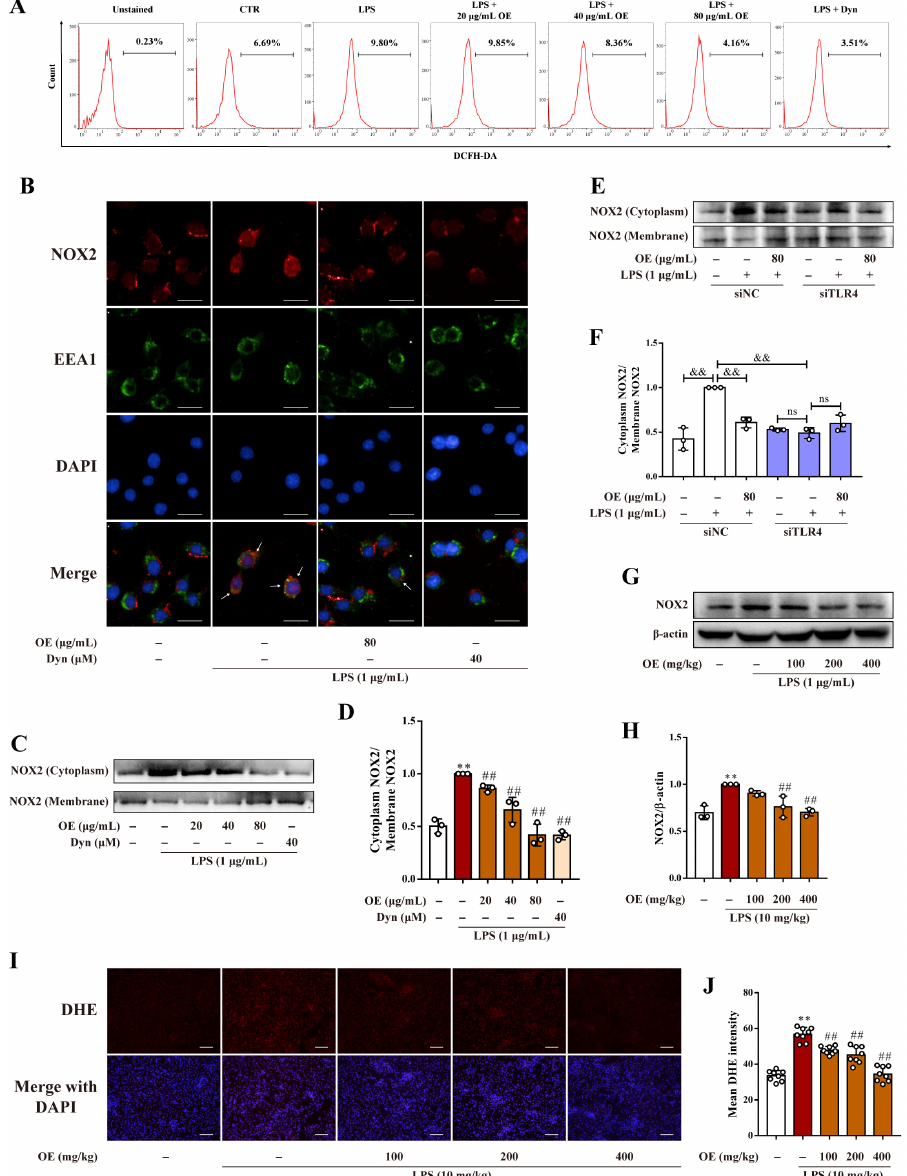
Figure 5. OE diminished ROS production by inhibiting NOX2 endocytosis. ( A ) RAW264.7 macrophages were pretreated with OE (20, 40, 80 µ g/mL) for 3 h or with Dyn (40 µ M) for 30 min fol- lowed by stimulation with LPS (1 µ g/mL) for 6 h. ROS production was measured by a ROS detection kit via flow cytometry. ( B – D ) RAW264.7 macrophages were pretreated with OE (80 µ g/mL) for 3 h or with Dynasore (40 µ M) for 30 min followed by stimulation with LPS (1 µ g/mL) for 4 h. Co-localization between NOX2 and EEA1 was determined by immunofluorescent staining (B). Scale bars: 20 µ m. The cytoplasmic and membranal protein expression of NOX2 were determined by a western blotting assay ( C , D ). ( E , F ) After transfecting siNC (100 nM) or siTLR4 (100 nM), RAW264.7 macrophages were pretreated with OE (80 µ g/mL) for 3 h followed by stimulation with LPS (1 µ g/mL) for 4 h. Cytoplasmic and membranal protein expression of NOX2 were determined by a western blotting assay. ( G – J ) Mice were administered OE (100, 200, 400 mg/kg) by gavage for 7 days followed by intraperitoneal injection of LPS (10 mg/kg) and feeding for another 12 h. The total protein expression of NOX2 ( G , H ) and ROS production ( I , J ) in mice kidneys were determined by a western blotting assay and DHE staining, respectively. Scale bars: 50 µ m. CTR: control. Data presented as Means ± SD. ** p < 0.01 vs. control group; ## p < 0.01 vs. LPS group; && p < 0.01; ns, no